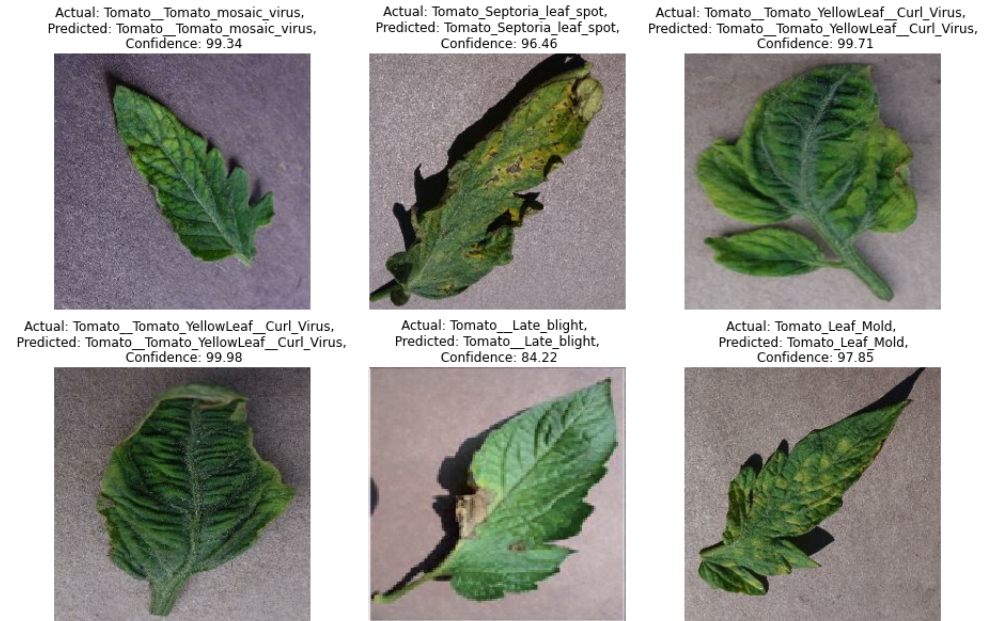
Figure 18. Test Result in Leaf disease detection by our DCLR